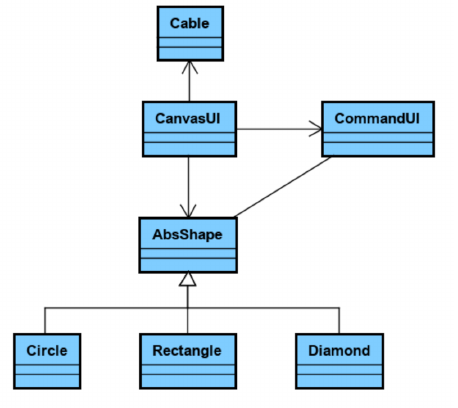
Figure 12. GCS architecture